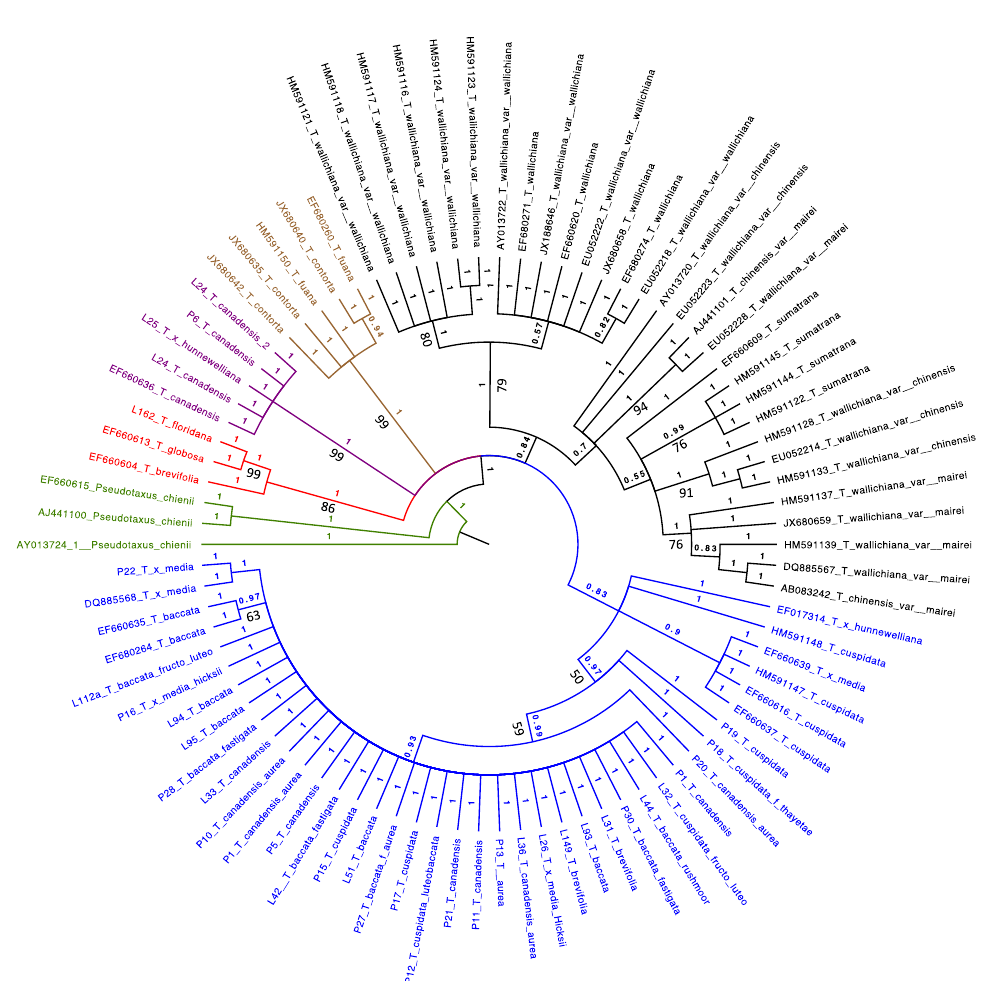
Figure 3. Bayesian inference tree of combined Taxus nrITS and plastid trnL and trnL-F sequences. Posterior probability values shown above the branches and maximum likelihood bootstrap analysis support the values shown below the branches. The relationship between T. baccata , T. canadensis and T. cuspidata are not well resolved. T. brevifolia is sister to T. globosa and T. flordiana . Taxus fauna groups with T. contorta . Taxus wallichiana is monophyletic and its varieties generally group together.